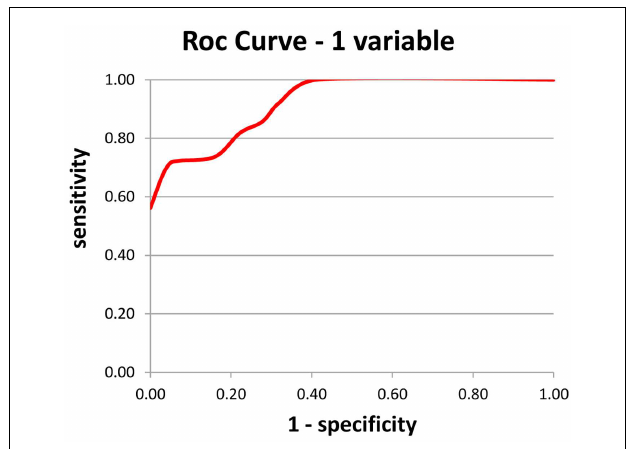
FIGURE 2 | Index 1 – using a single variable – the alpha/theta ratio of the mean potential of the O1 electrode; a: sensitivity and b: specificity .